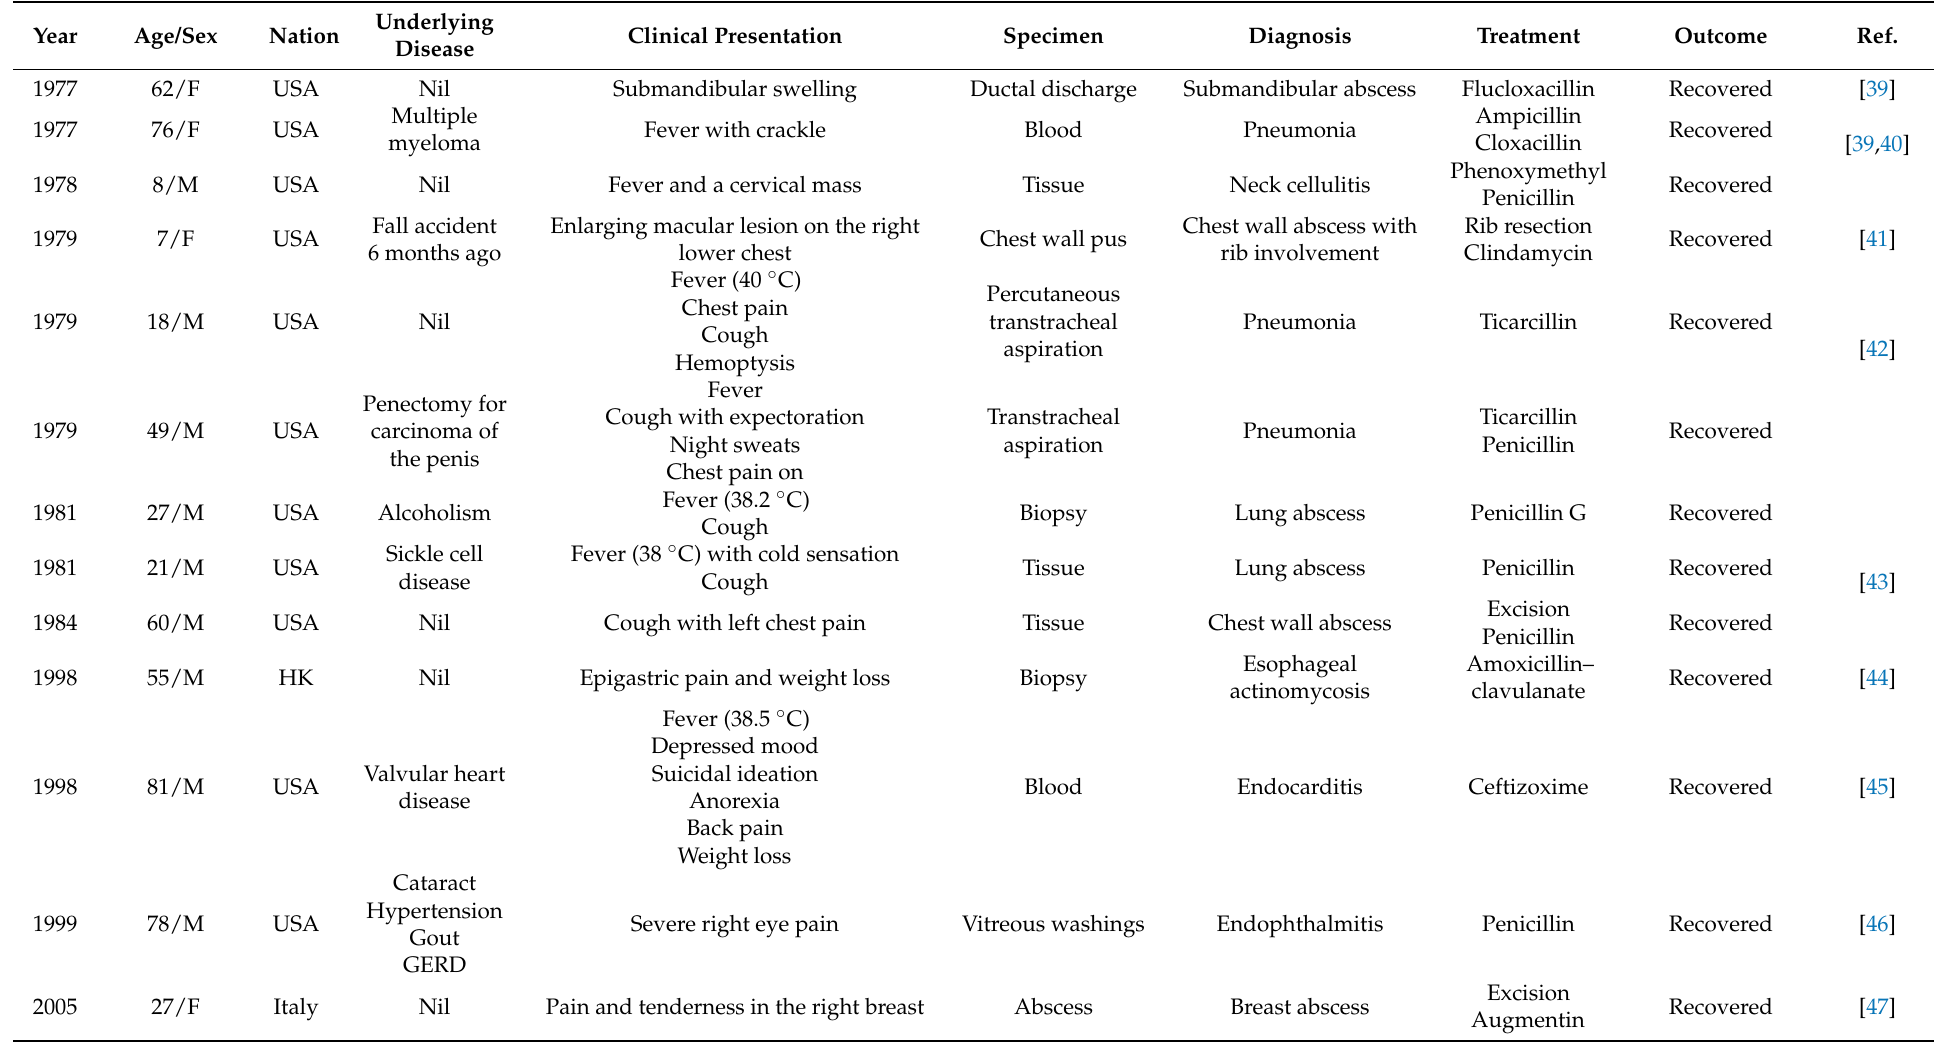
Table 2. Characteristics of Actinomyces viscosus infection published from 1977 to